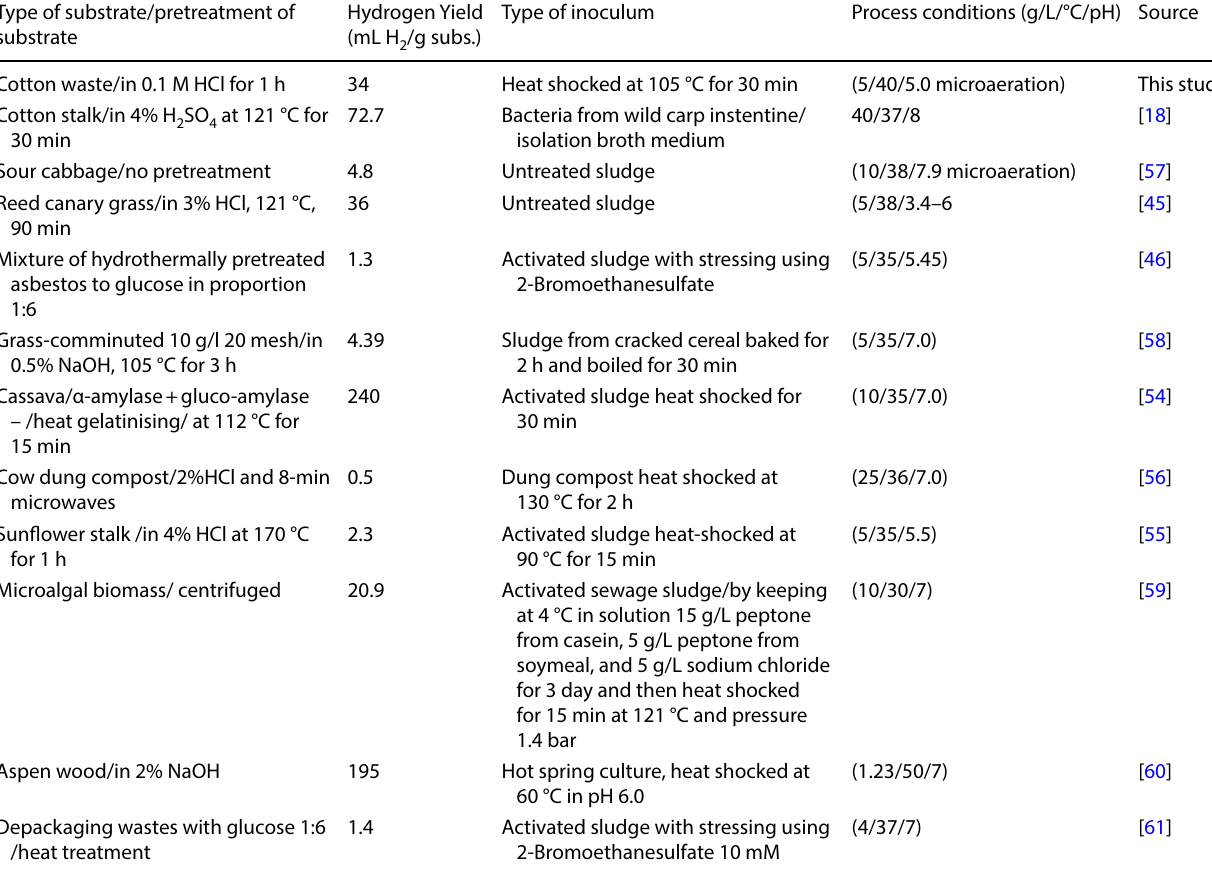
Table 2 Comparison of hydrogen production from different substrates (batch process) Type of substrate/pretreatment of